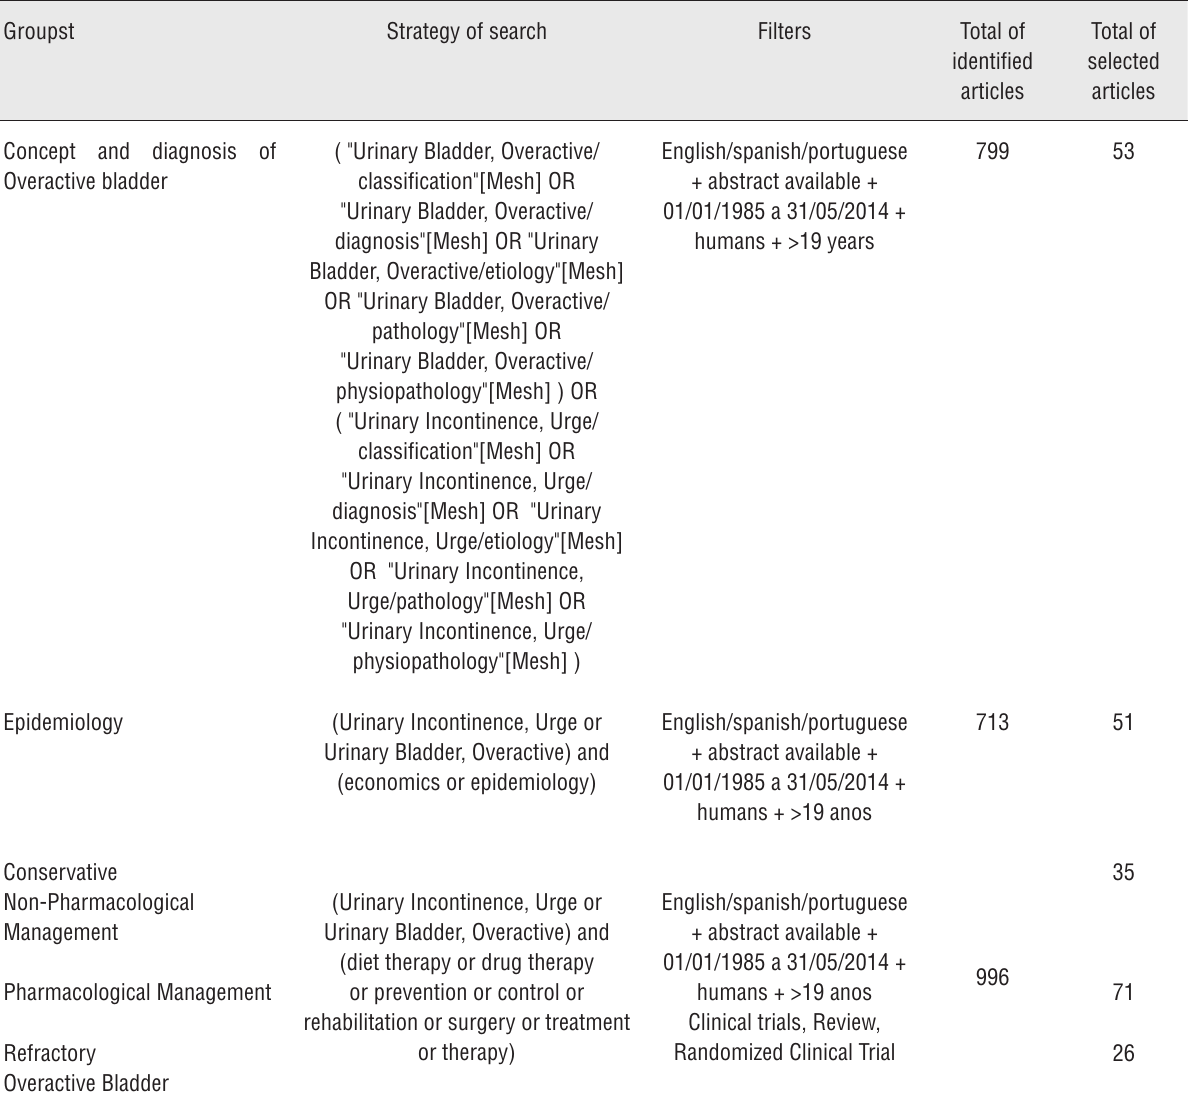
selected identified articles articles